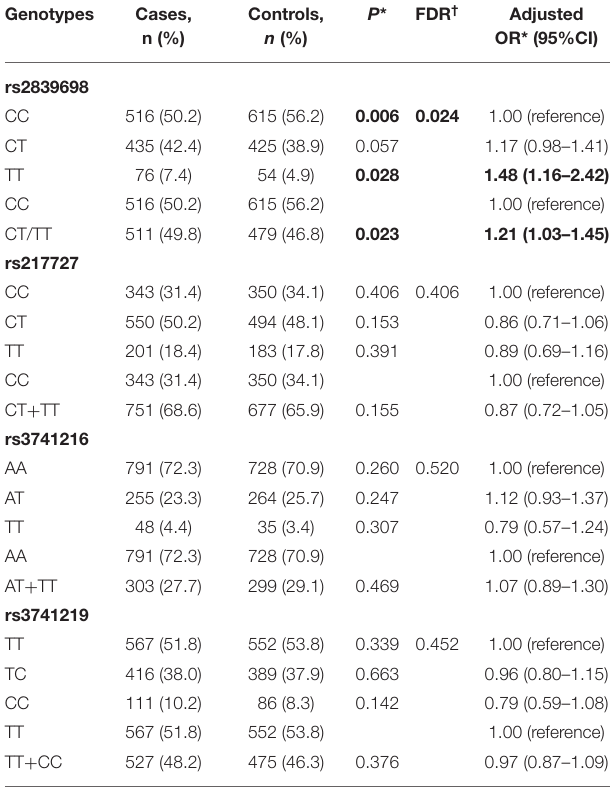
TABLE 1 | Genotype frequencies of the H19 polymorphisms among the cases and controls and their associations with risk of RCC.